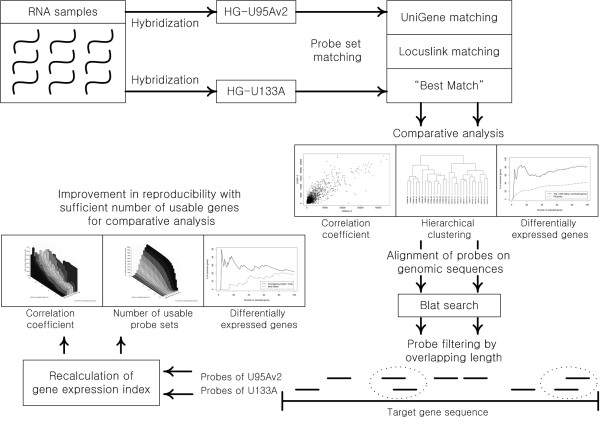
A schematic view of the procedure. The same RNA was hybridized on both HG-U95Av2 and HG-U133A arrays, for 14 samples. Three methods for matching the probes were considered, but the two datasets gave highly inconsistent results in cluster analysis and identification of differentially expressed genes. To improve the comparability in general, probe-level sequence information was exploited. All 25-mer probes were aligned to human genome sequences by BLAT and then filtered based on the length of their overlap with the probes on the other array. New expression indices were calculated using only the selected probes, and this results in higher reproducibility.